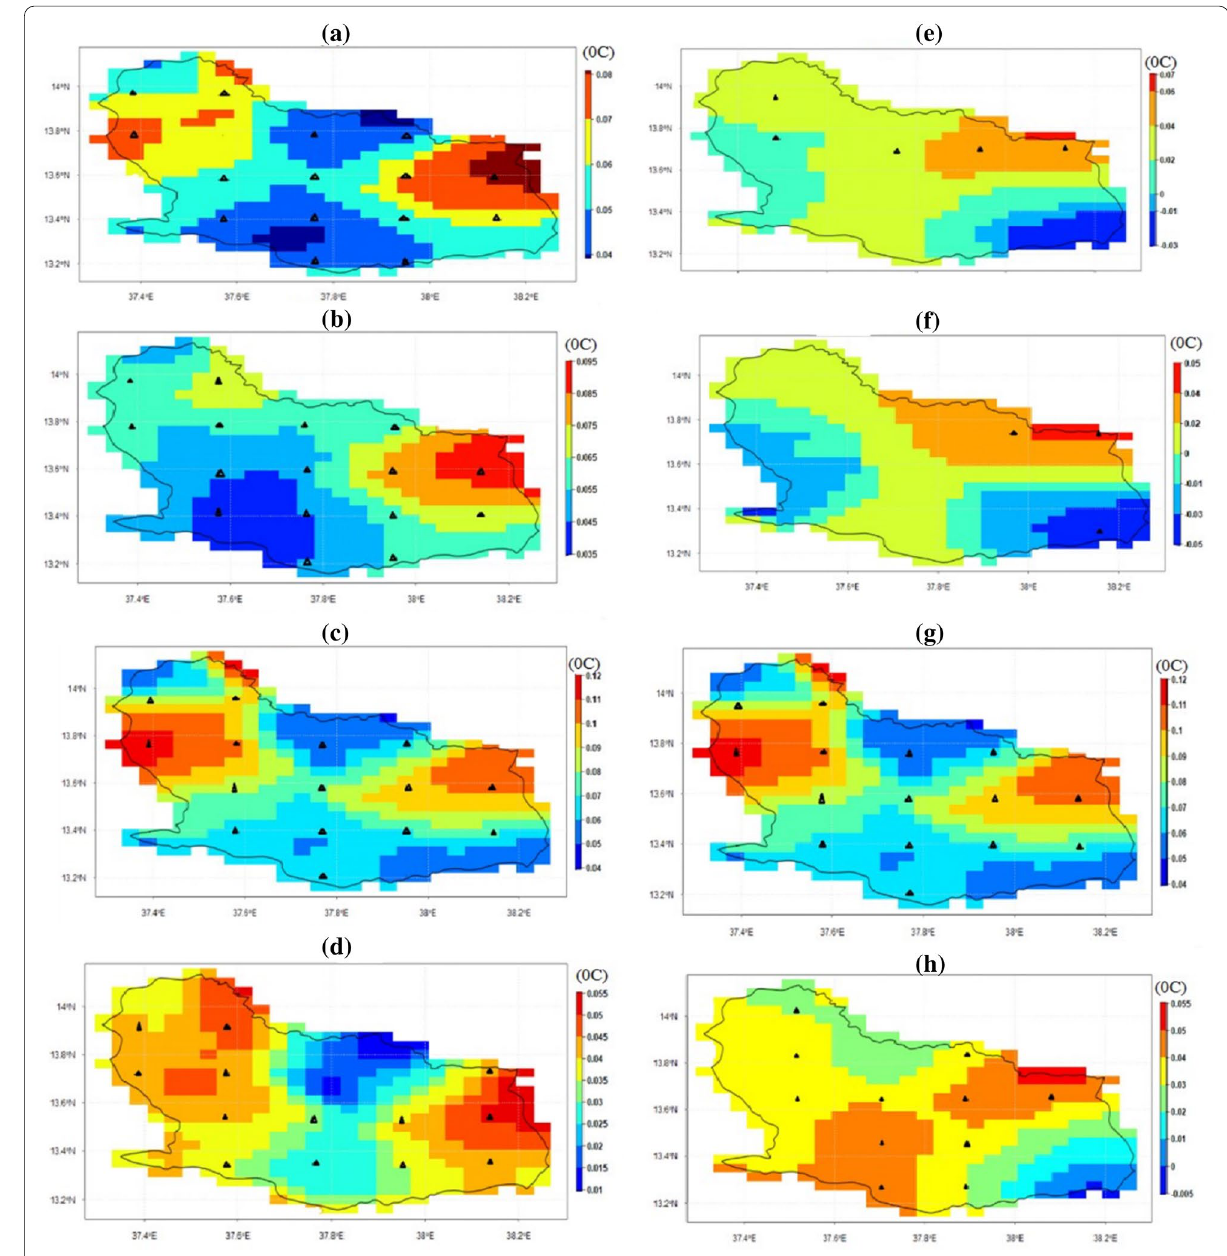
Fig. 15 Trend and magnitude Annual ( a ), Bega season ( b ), Belg season ( c )and Kiremit season ( d ) mean maximum temperature Annual ( e ), Bega season ( f ), Belg season ( g ) and Kiremit season ( h ) mean minimum temperature ( grides showed statistically significant trend at P